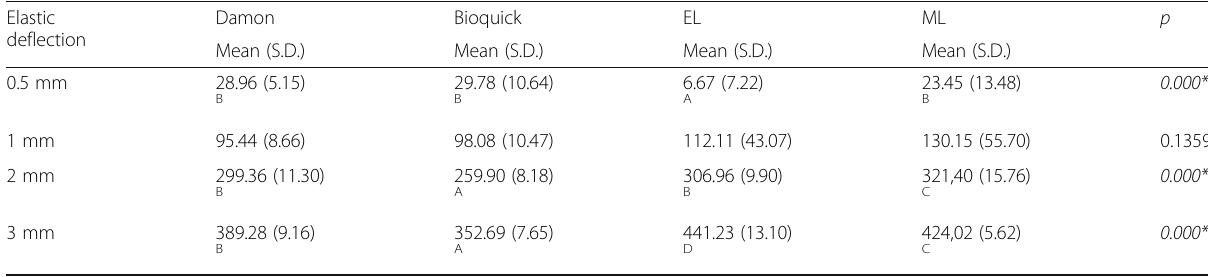
*Statistically significant at p<